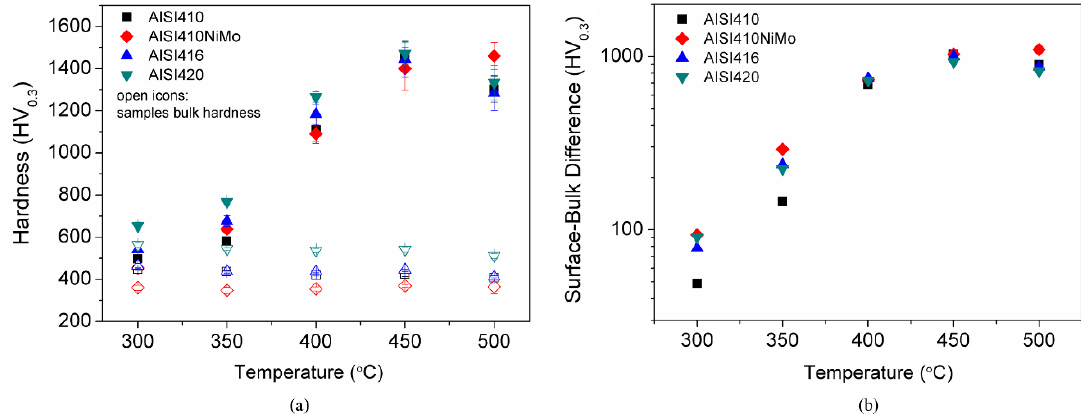
Figure 5. (a) Hardness of the nitrided surface (filled icons), and sample bulk (opened icons) for all studied steels and temperatures; and (b) the related (nitrided)surface-bulk(of the sample) hardness difference. Treatments carried out for 4 h, using a gas mixture composition of 70% N +20% H +10% Ar, at a flow rate of 3.33×10 6 Nm 3 s −1 and pressure of 3 Torr. 2 2